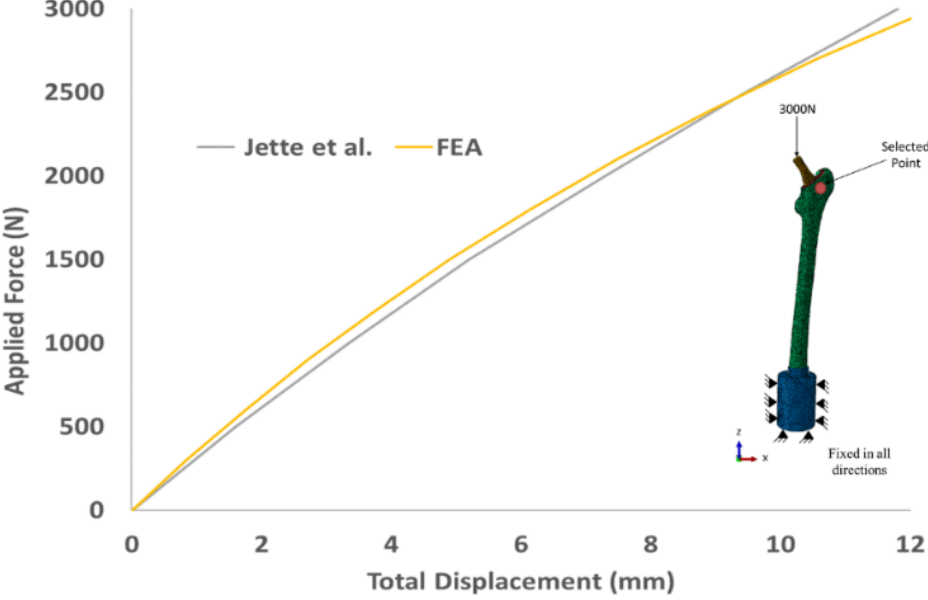
Figure 10. Stem–bone assembly Figure 10. Stem – bone assembly validation.